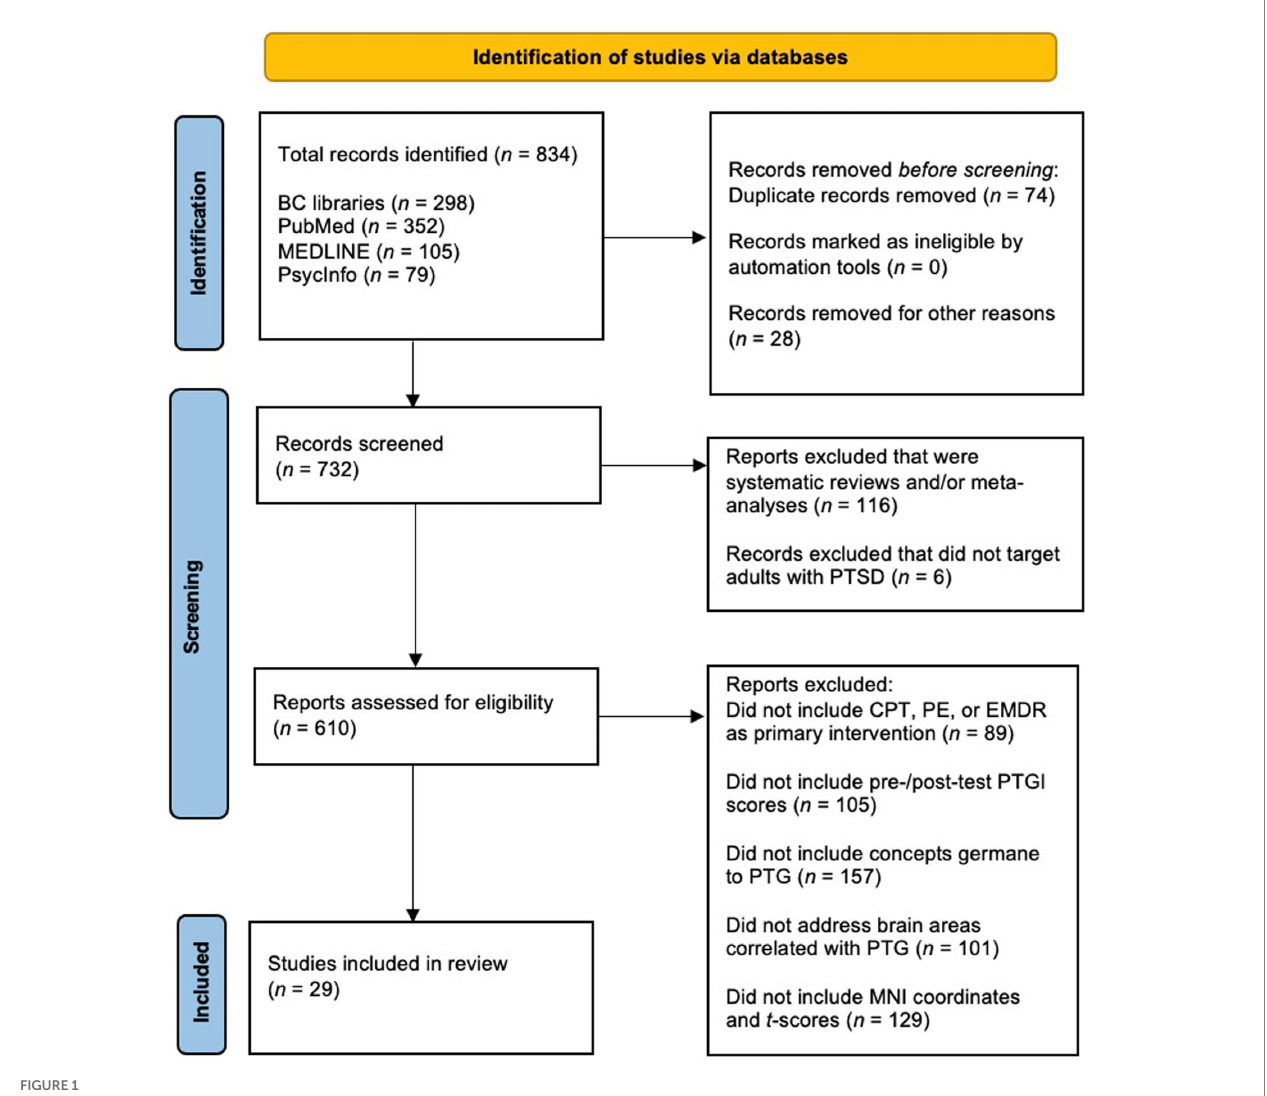
FIGURE 1 PRISMA flow chart of systematic review